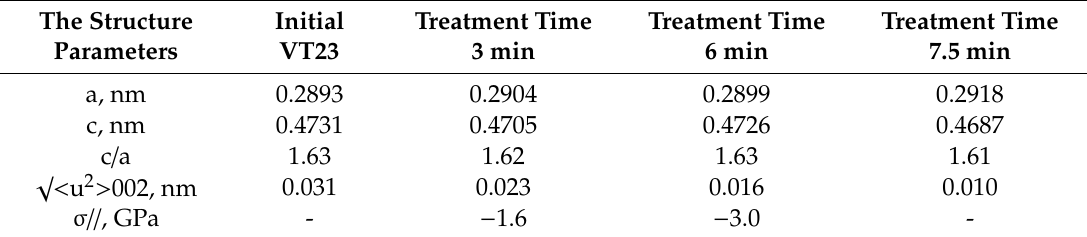
Table 3. The crystalline lattice parameters, the compressing macrostresses σ // , the rms displacements √ (cid:104) u 2 (cid:105) for direction < 002 > of the surface layer at di ff erent treatment durations of the titanium of atoms alloy with copper